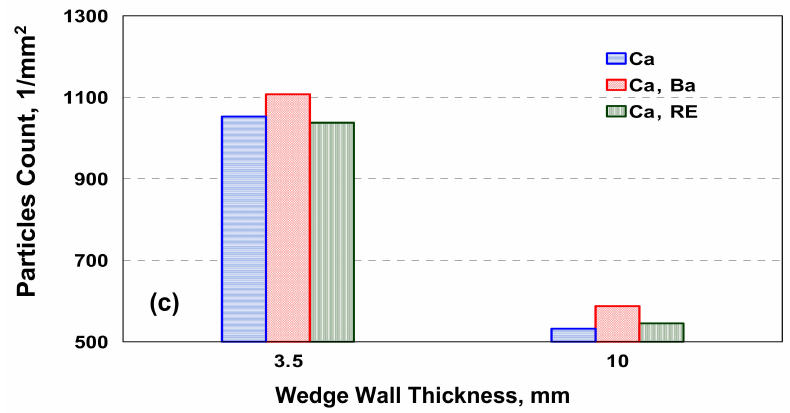
Figure 4. Average graphite particles characteristics. ( a ) area; ( b ) standard deviation in particles area values; ( c ) particle count.